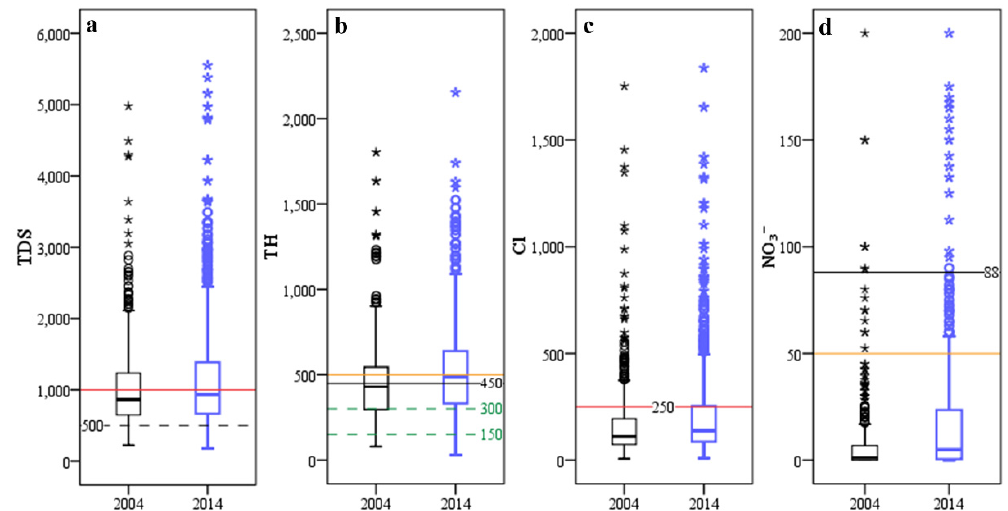
Figure 7. Box plots of samples in 2004 and 2014 for ( a ) total dissolved solids (TDS), ( b ) total hardness (TH), ( c ) Cl , and ( d ) NO — N. The red line indicates the permissible limits according to both WHO and Chinese standards, whereas the orange and black lines represent different permissible limits by WHO and Chinese standards, respectively. The dotted green line indicates TH classification.